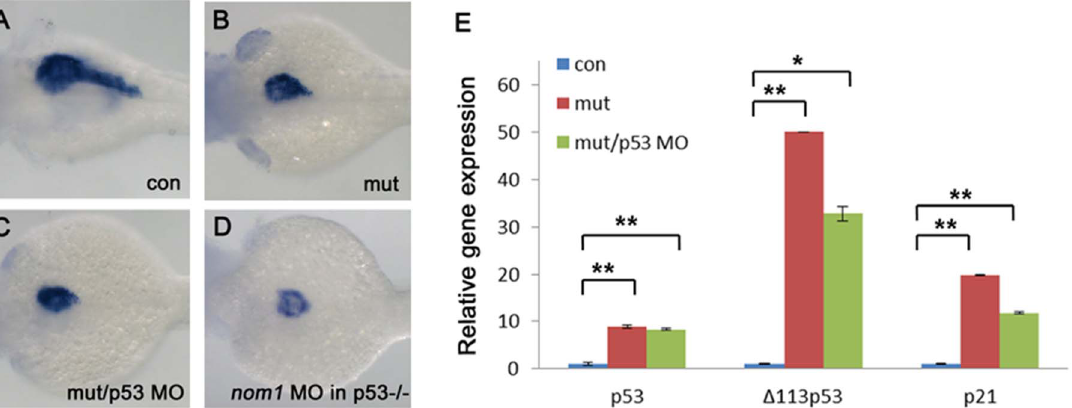
Figure 8. Nom1 -induced pancreas defect is p53 independent. (A–D) Lateral views, anterior to the left. (A) control group at 3 dpf. (B) dg5 mutant group at 3 dpf. (C) Failure to rescue the pancreas defect by injection of 4 ng p53MO into dg5 mutant or (D) injection of nom1 MO in p53 M214K mutant. (E) Expression of p53 and its targets D 1113p53 and p21 are increased in dg5 nom1 mutant, as assessed by quantitative PCR. Error bars mean 6 SD. ** P , 0.01, * P , 0.05.